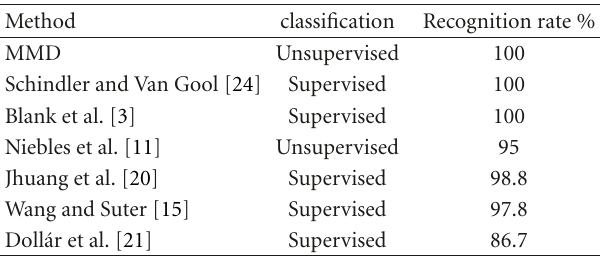
Table 1: Comparison of recognition results on Weismann dataset with di ff erent approaches.